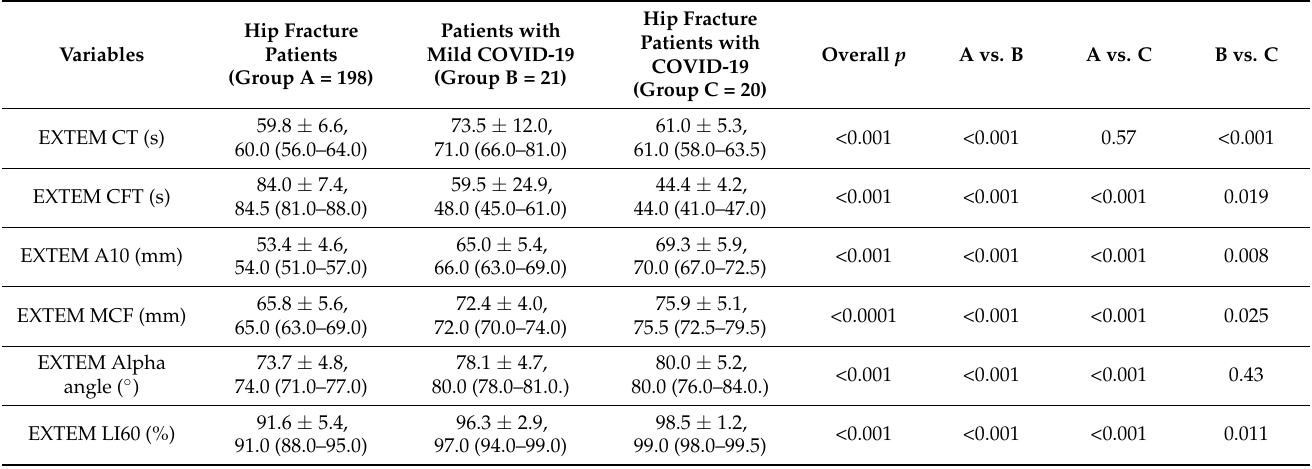
Table 3. Extrinsically activated rotational thromboelastometry test (EXTEM) parameters among the study groups.